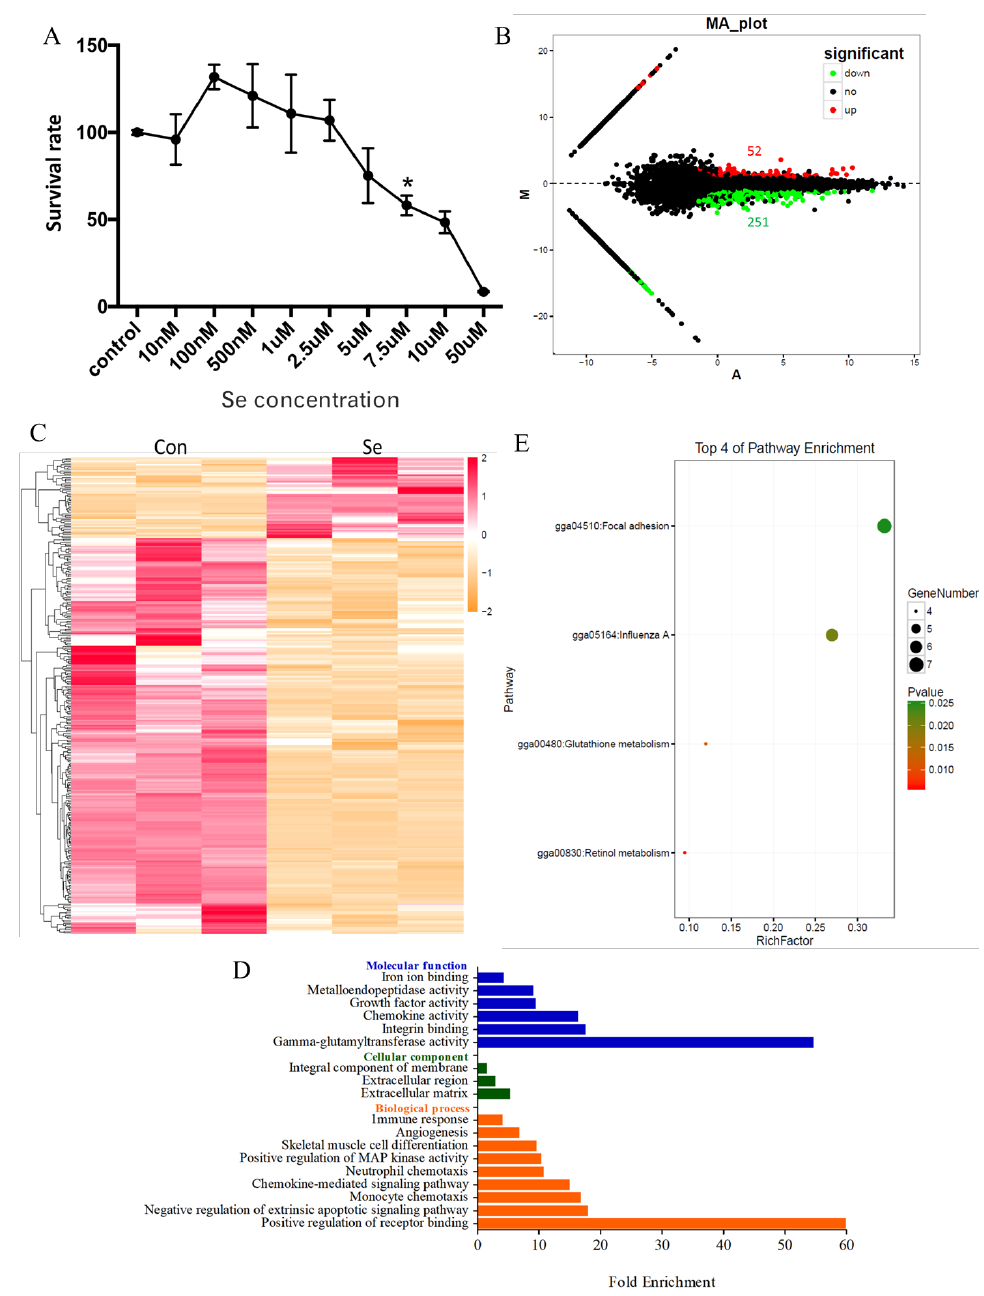
Figure 1. Selenium treatment at an appropriate concentration can promote the survival rate and a ff ect retinol and glutathione metabolism in HD11 cells. ( A ) The survival rate of HD11 cells at di ff erent concentrations of Se (sodium selenite) after 24 h. Se at concentrations ranging from 100 nM to 2.5 uM promoted the survival rate of HD11 cells (* indicates the significant di ff erence ( p < 0.05)). ( B ) The number of DEGs between the control group (Con) and Se-treated group (SE). There were 52 up-regulated genes and 251 down-regulated genes following Se treatment. ( C ) The expression profiles of DEGs between the control group (Con) and Se-treated group (SE). ( D ) The major over-represented GO terms of di ff erentially expressed genes between the control group (Con) and Se-treated group (SE). ( E ) The major over-represented KEGG terms of di ff erentially expressed genes between the control group (Con) and Se-treated group